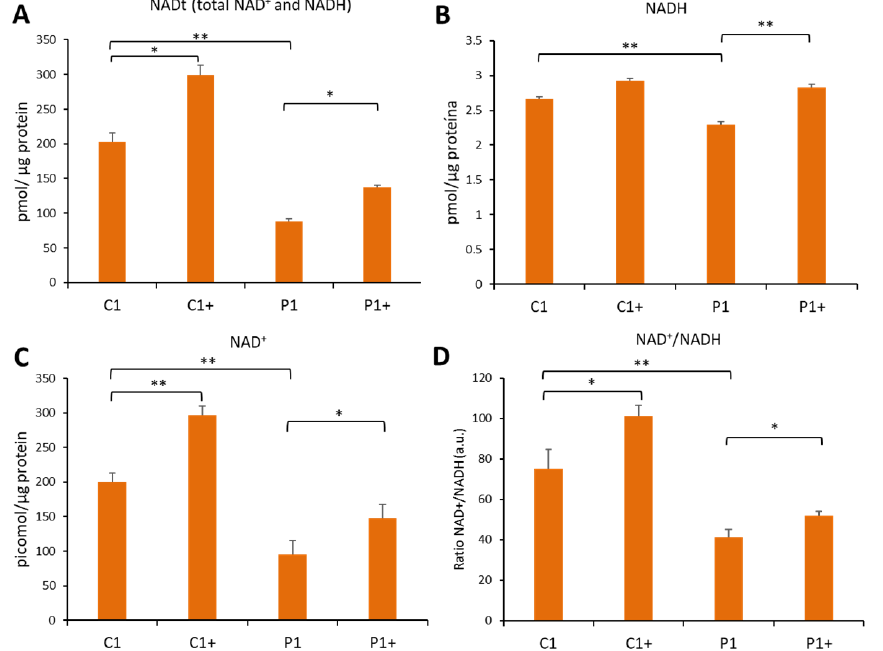
Figure 5. Pantothenate and L ‐ carnitine supplementation increases cellular NAD+/NADH levels in KAT6A mutant fibroblasts (P1) . Control (C) and KAT6A fibroblasts (P1) were treated for 15 days with 0.7 μ M pantothenate and 0.7 μ M L ‐ carnitine (C+ and P1+). NAD+/NADH assay was performed using the NAD+/NADH Assay Kit. NADt (total NAD+ and NADH) ( A ) and NADH ( B ) were quan ‐ tified as described in the Materials and Methods section. NAD+ was calculated by subtraction (NADt–NADH) ( C ) and NAD+/NADH ratio was calculated by the equation ((NADt ‐ NADH)/NADH ( D ). Data represent the mean ±SD of three separate experiments. * p ‐ value < 0.05 and ** p ‐ value < 0.01.